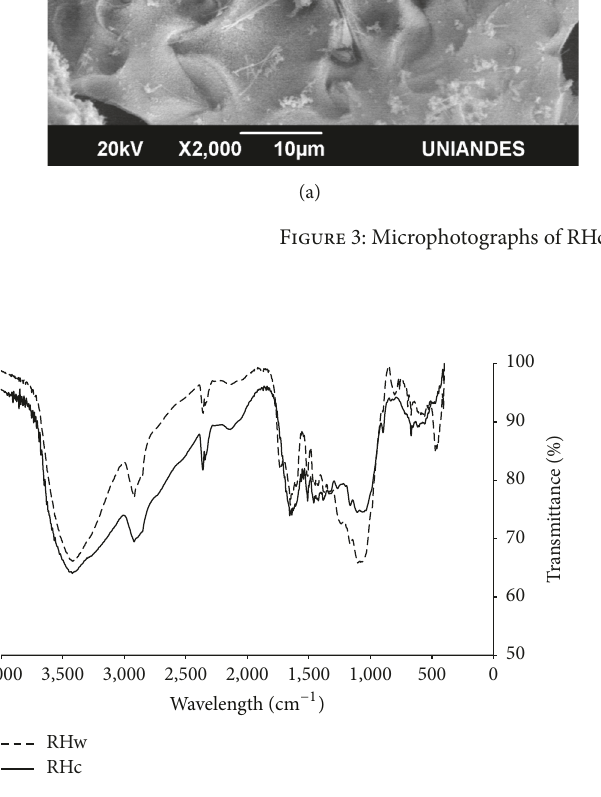
Figure 4: IR spectrum of RHw (dashed line) and RHc (solid line) samples.